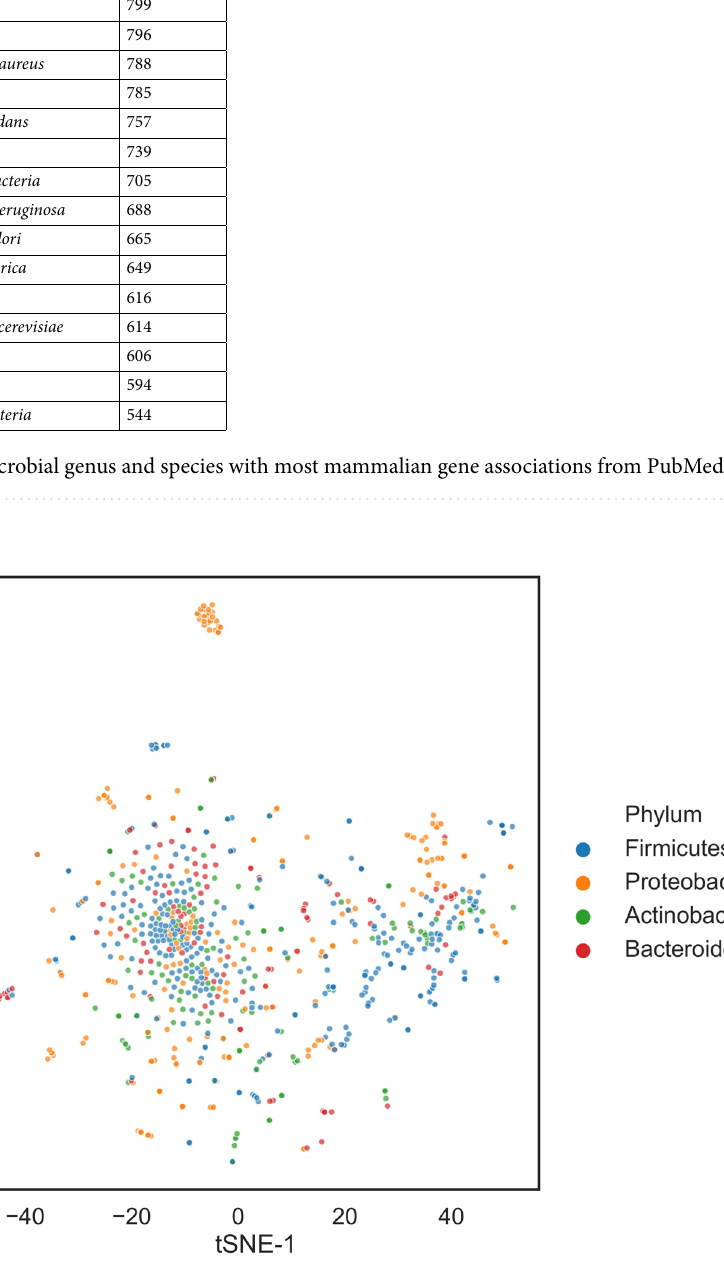
Figure 2. t-SNE visualization of the normalized microbe-gene co-mentioning matrix derived from PubMed queries for the microbes from the following four phyla: Firmicutes , Proteobacteria , Bacteroidetes , and Actinobacteria . The t-SNE was applied to the TF-IDF normalized (see “Methods”) microbe-gene co-mentioning matrix to calculate the 2-D coordinates for individual microbial genus or species. Each dot in the scatter plot represents a microbial genus or species, which is colored by their respective phylum based on Greengenes